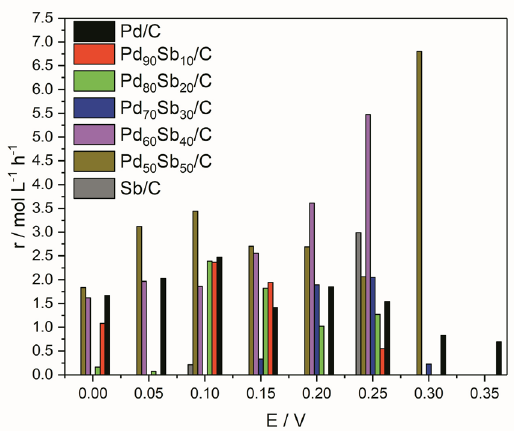
Figure 8. Methanol concentration obtained for PdSb / C materials and